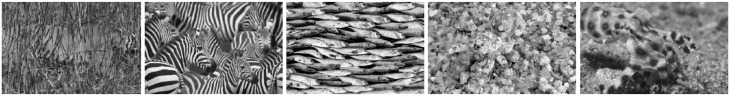
Repetitive patterns, swarm motion, and body morphing disrupt detection of unique invariant features (i.e., rigid animal silhouettes). Examples of natural images are acquired from public Creative Commons sources (http://search.creativecommons.org/).